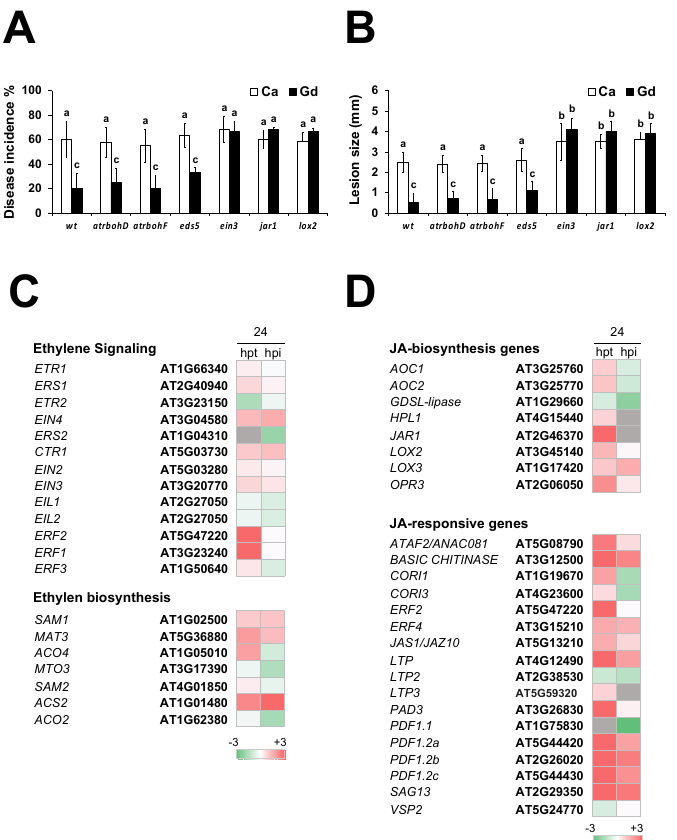
Figure 8. Role of ROS, SA, and JA in Gd-induced resistance to B. cinerea in A. thaliana . The AtrbohD, AtrbohF, eds5, ein3, jar1, and lox2 mutants were evaluated. ( A ) Four-week-old A. thaliana plants were sprayed until saturation with 0.2 g/L of Ca or Gd. After 24 hpt, 3 μ L droplets containing a B. cinerea spore suspension (5 × 10 4 spores mL − 1 ) were applied and disease incidence was determined by measuring the percentage of plants showing disease symptoms at 72 hpi. ( B ) The disease severity was determined by measuring the lesion size of all the infected leaves. Heatmaps of the expression of log2-fold changes in ET- ( C ) and JA-related genes ( D ), compared to the corre- sponding controls, from RNAseq data at 24 hpt and hpi. Bars represent mean values (±SD) of three independent experiments ( n = 50). Different letters above each bar represent statistically significant differences according to the Scott–Knott test ( p < 0.05).